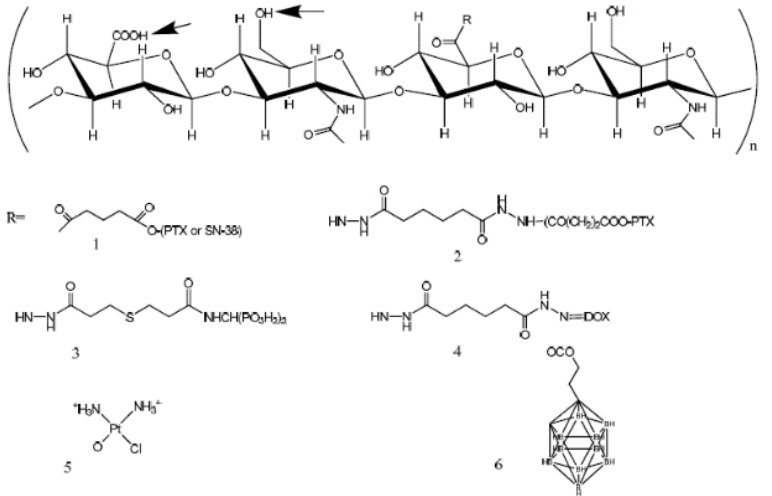
Figure 2. Hyaluronic acid (HA) and small molecule conjugates. Arrows indicate chemical modification sites of HA and R is link between HA and the anticancer drugs. Anticancer drugs are conjugated with HA at the carboxyl and hydroxyl groups of HA through ester linkages or amide linkages